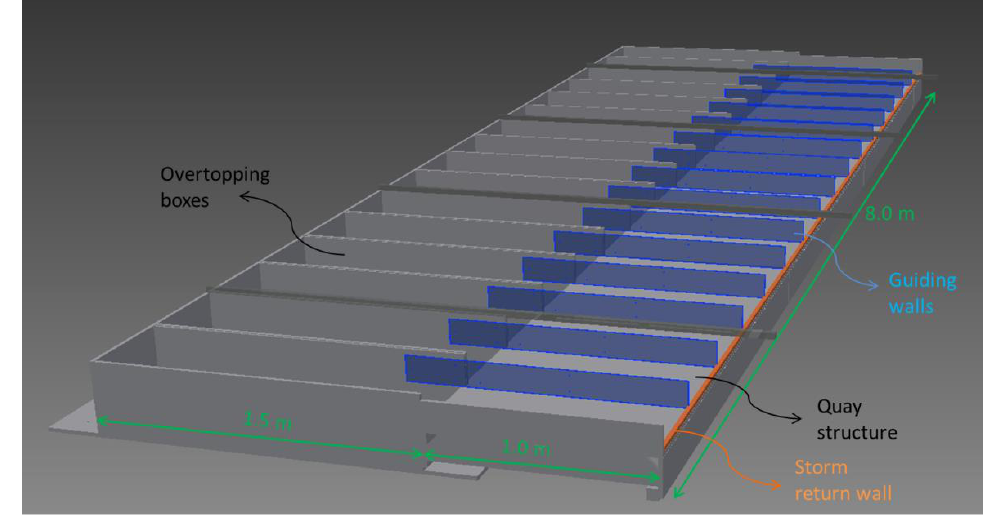
Figure 2. The structure used during the experiment.